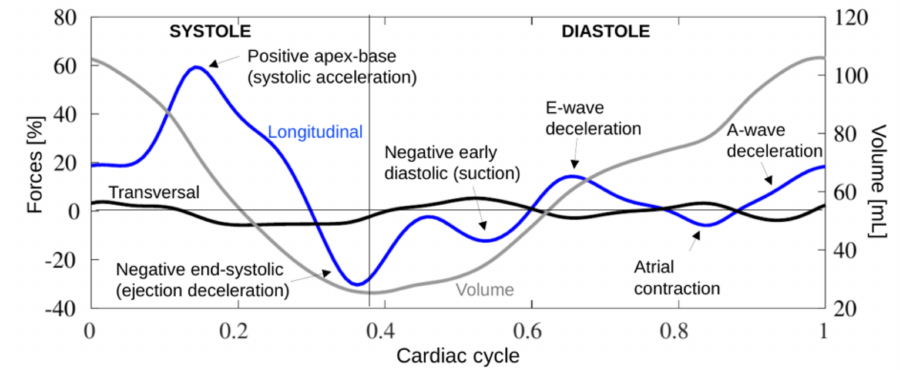
Figure 2. Typical time evolution of left ventricular hemodynamic forces over the cardiac cycle. The blue line shows apical-basal LV longitudinal forces, larger positive compared with transversal components (black line). Acceleration toward the base accounts for the systolic peak acceleration, after which deceleration causes the late systolic negative peak. Coinciding with the onset of diastole, another small negative early peak (suction) appeared, corresponding to early passive filling of the left ventricle (E-wave). A similar pattern was seen toward the end of diastole, corresponding to atrial contraction (A-wave). The grey line shows the LV volume over the cardiac cycle.